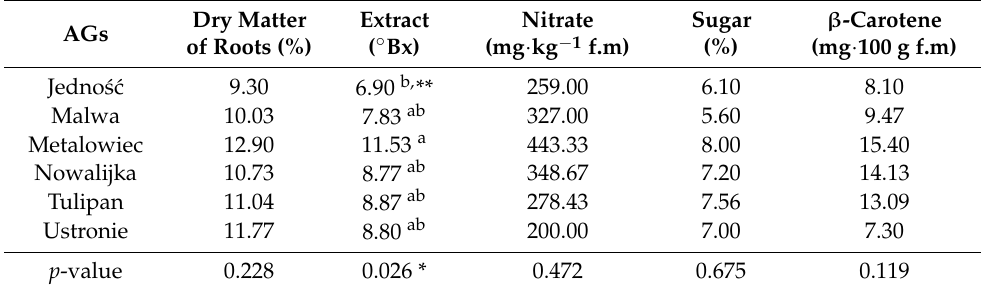
Table 10. The content of dry matter, extract, nitrate, sugar, and β -carotene in the roots of Daucus carota subsp. sativus growing in six allotment gardens of Gorz ó w Wielkopolski.